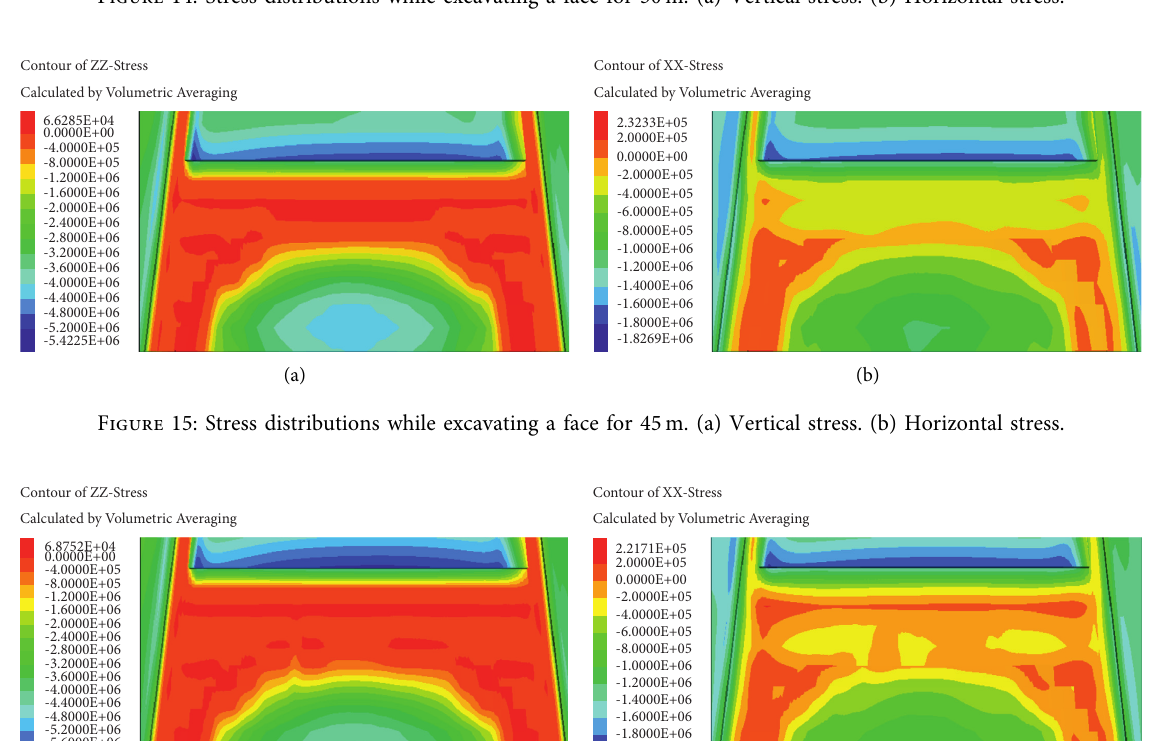
Figure 14: Stress distributions while excavating a face for 30m. (a) Vertical stress. (b) Horizontal